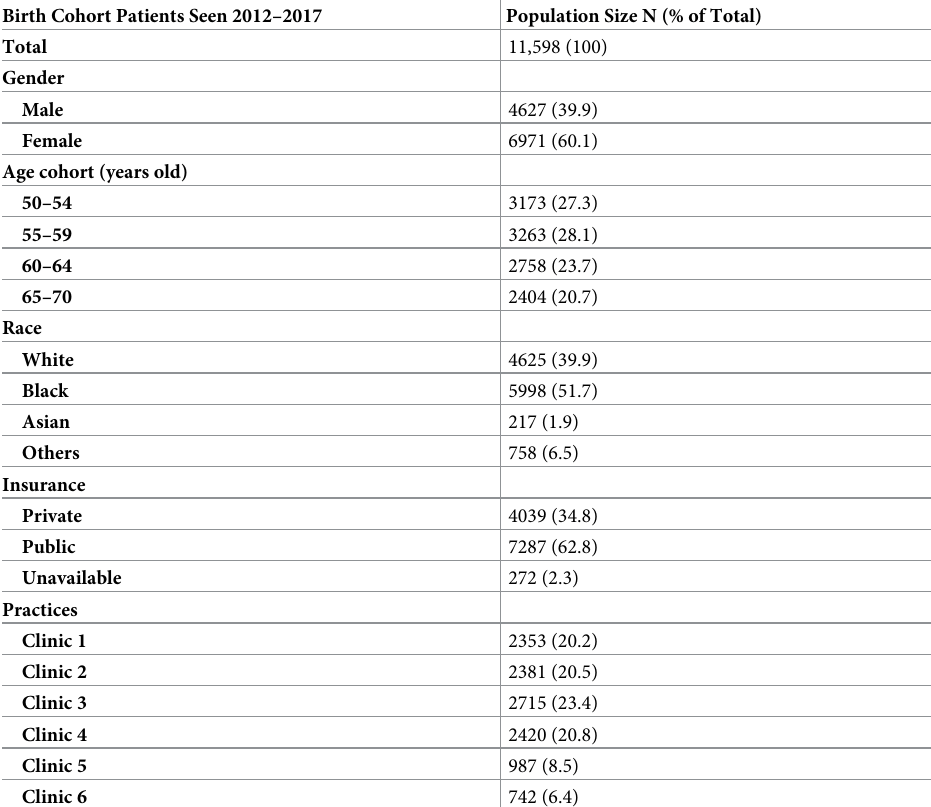
Table 1. Baseline characteristics of eligible